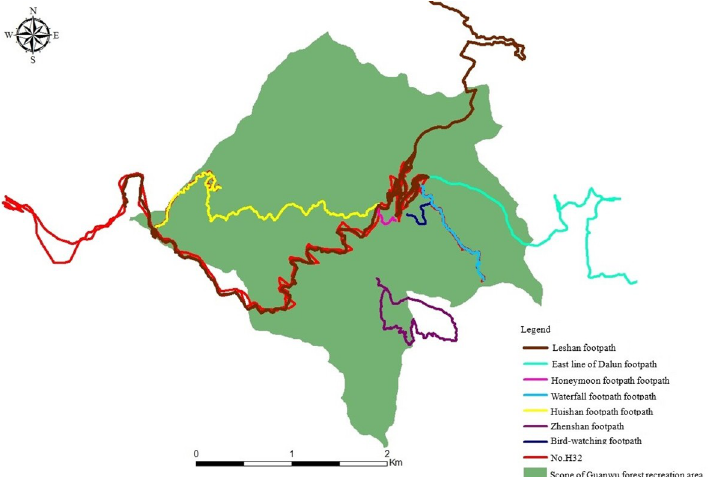
Fig 4. Map showing the recreational activities of tourists to the Guanwu National Forest Recreation Area in Taiwan.